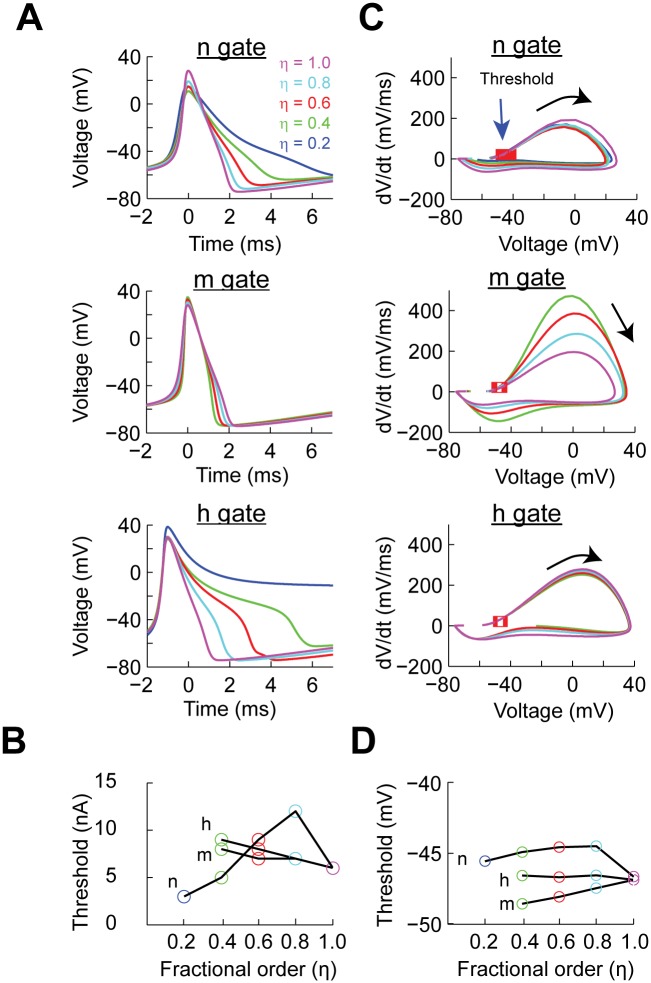
The effect of power-law behaving Hodgkin-Huxley gating variables on the shape and properties of the action potential.(A) Action potential shapes generated with the minimum input current as a function of the order of the fractional derivative (η) for the respective gate. (B) The action potential current threshold as a function of input current and η. (C) Phase plot of the action potentials generated at minimum input current as function of η. The red squares indicate the crossing of threshold detection (dv/dt > 20 mV/ms). (D) The voltage threshold calculated from the phase plots in C.